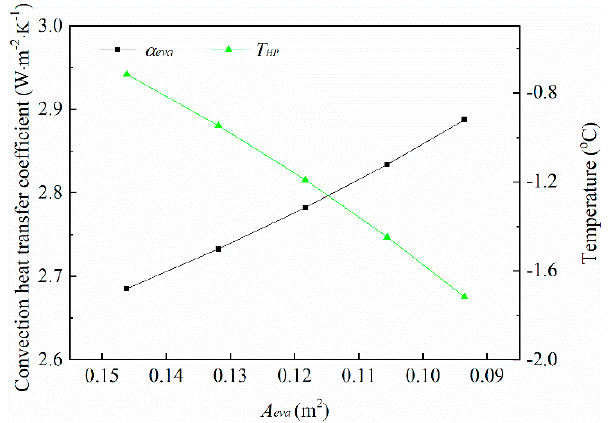
Figure 12. Heat transfer characteristics of the heat pipes at A eva .